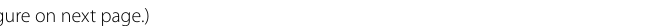
ulceration(See figure on next Fig. 3 CZA Lorikeet enteritis gross and histopathology. a Enteritis versus non‑enteritis deaths by month (2015–2019). Cases were diagnosed histologically. b–d Gross necropsy findings typical of lorikeets with enteritis. b Feathers plucked demonstrating decreased pectoral muscle mass and prominent keel. c Formalin fixed tissues: severely dilated loops of intestines, including paired ceca, with thin intestinal walls and segments of thickened and nodular intestines. d Formalin fixed loop of small intestine: Mesentery thickened by pale tan tissue and nodules on the wall and serosa. e Hematoxylin & eosin stain (H&E) of chronic necrotizing enteritis in a lorikeet. Intestinal loops are markedly dilated with thinning of intestinal wall and replacement with fibrosis. Lumens impacted with coagulum of degenerate red blood cells, bacterial colonies and sloughed mucosa that compress the remaining atrophied and blunted intestinal villi. Inflammation on serosa and adjacent mesentery. f H&E of acute transmural necrotizing and ulcerative enteritis in a lorikeet. Sparse remaining mucosa characterized by large central ulcer, inflammatory cells including macrophages and heterophils throughout intestinal wall centered around the ulcer and overlying large colonies of bacteria. g Modified Brown‑Hopps of f intestinal section. Superficially adhered bacterial colonies within the lesion are monomorphic large gram‑positive bacilli. h H&E of enteritis: Little remaining mucosa with large central focus of ulceration, numerous heterophils and macrophages, followed by a layer of fibrin and degenerate red blood cells with admixed large bacterial colonies and sloughed necrotic mucosal epithelium. i Immunohistochemistry (IHC) against Clostridium perfringens from ( h ) intestinal section. Box indicates region in ( j ) under higher magnification. j IHC against C. perfringens within indicated region from ( i ). Light brown staining is non‑specific labeling of sloughed necrotic mucosa and hemorrhage. Punctate dark brown staining indicates immunolabeling of bacteria within necrohemorrhagic coagulum and focus of